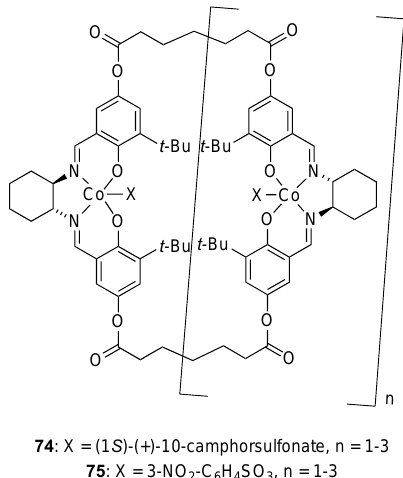
Figure 30. Jacobsen and coworkers’ [115] second generation of oligosalen catalysts 74 and 75 .